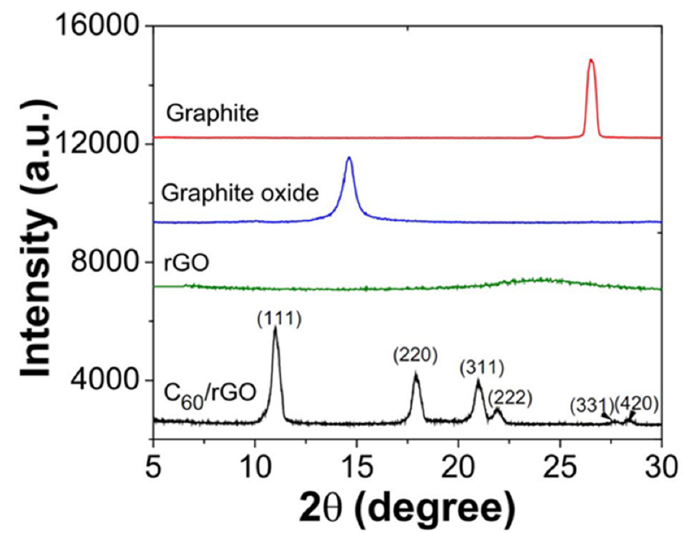
Figure 15. XRD diffraction patterns of graphite and its derivatives [152] (CC BY). Chieng et al. [183] prepared nanocomposite by blending poly(lactic acid) (PLA)/epoxidized palm oil (EPO) with graphene nanoplatelet (xGnP). The PLA/EPO/xGnP green nanocomposites were characterized by XRD. Figure 16 displays the XRD spectra of xGnP, PLA/EPO and PLA/EPO composite with different xGnP loading. The xGnP displays a strong peak at 2 θ = 26.4°. The XRD spectra of PLA/5EPO blend and PLA/5EPO with different xGnP loadings display a broad characteristic peak of PLA ma- trix at 2 θ = ~16°. PLA/5EPO nanocomposites with 0.3 wt.% xGnP loading display a small peak around 26.5°, which corresponds to the characteristic peak of xGnP. Figure 16. XRD patterns of different graphene nanocomposites. Reproduced from [183] (CC BY). 6. Mechanical Properties of Graphene-Based Nanocomposites Graphene-based nanocomposite materials exhibit significant improvement in me- chanical properties compared to the standard composites [2,46,184–187]. Graphene has been commonly used to strengthen mechanical properties of several nanocomposites [185,186]. For example, the tensile strength of the baseline epoxy was enhanced by ~40%